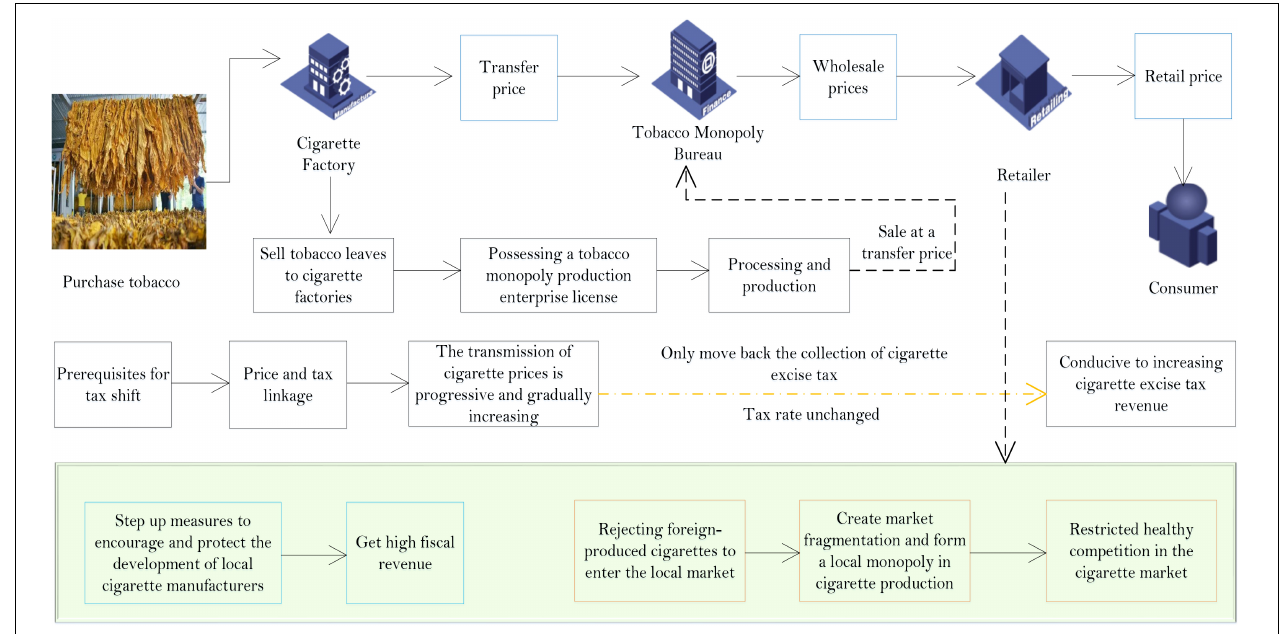
FIGURE 2 | The process of the tobacco